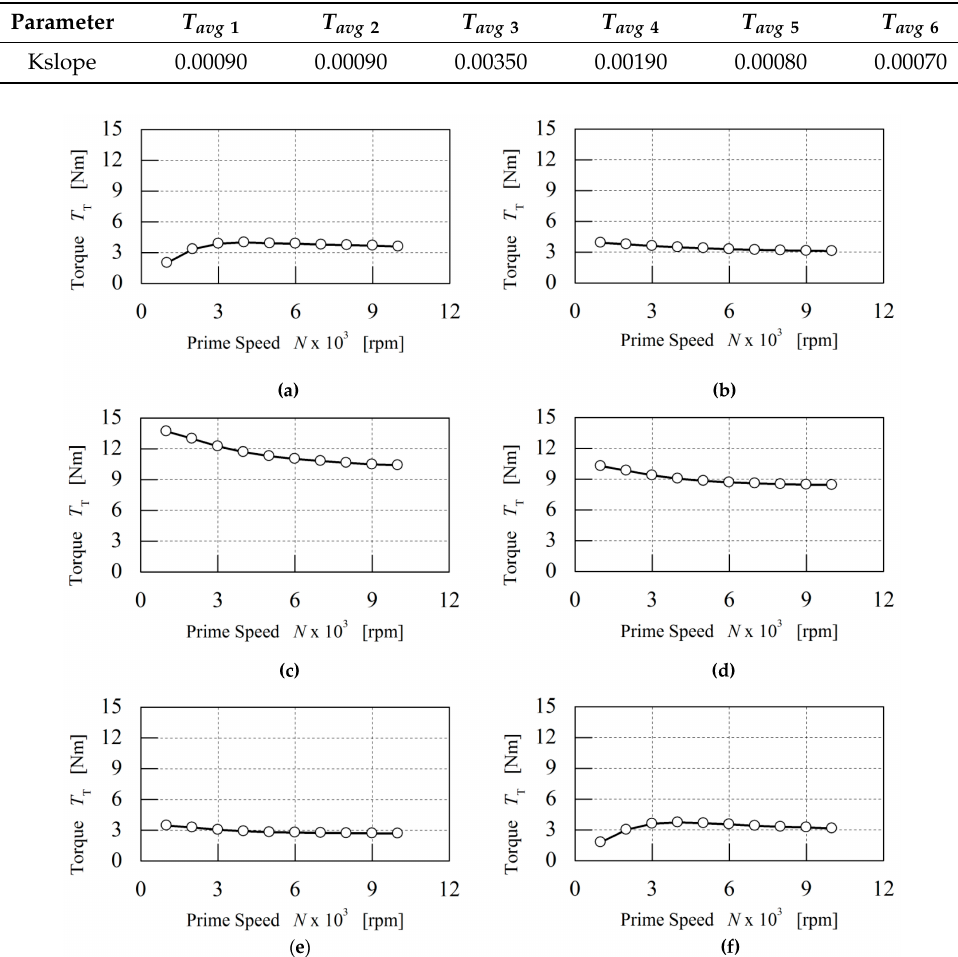
Table 7. Comparison of distribution torque speed constants with load.